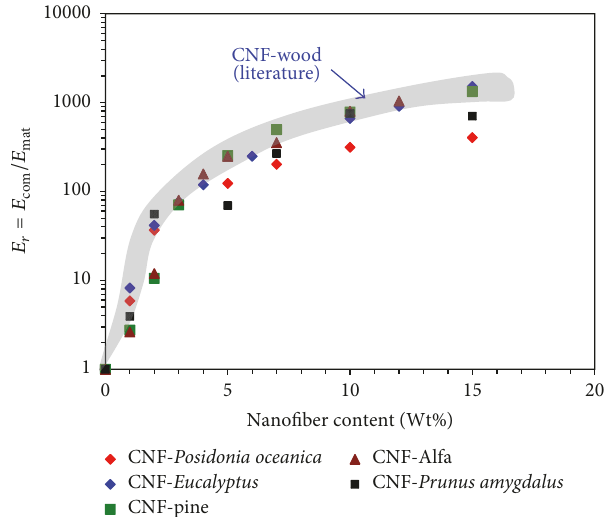
Figure 6: Evolution of the relative storage modulus 𝐸 𝑟 = 𝐸 𝑐 /𝐸 mat versus temperature at 1Hz for nanocomposites based on CNFs at 70 ∘